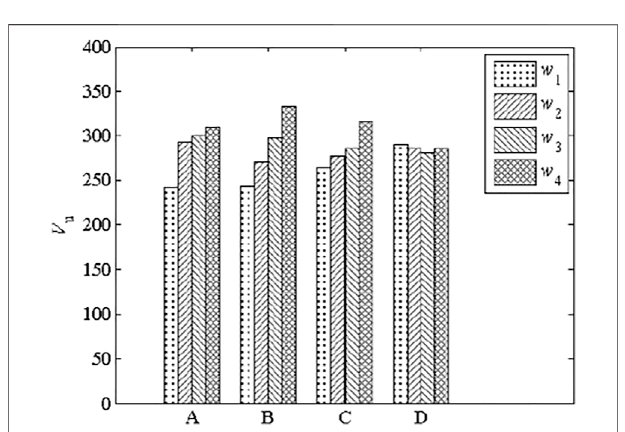
FIGURE 16 | In fl uence of the four factors on the ultimate capacity of HSFGBs.